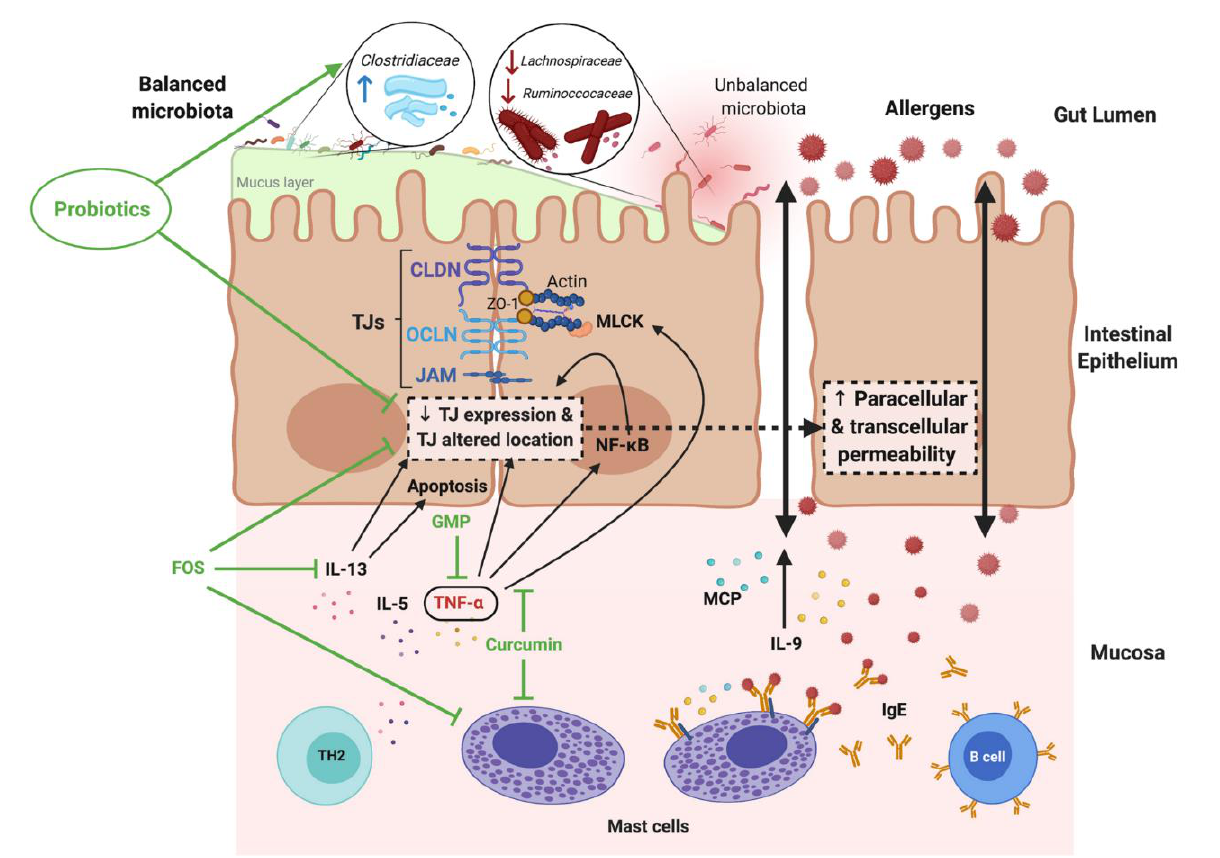
Figure 2. Increased intestinal permeability in food allergy (FA) and the modulatory effects of probiotic, prebiotic and food components. Reprinted with permission from Ref. [77]. 2021, Salinas, E. IL- interleukin; TNF- α - tumor necrosis factor α ; CLDN- claudins; OCLN- occludins; GMP- gly-